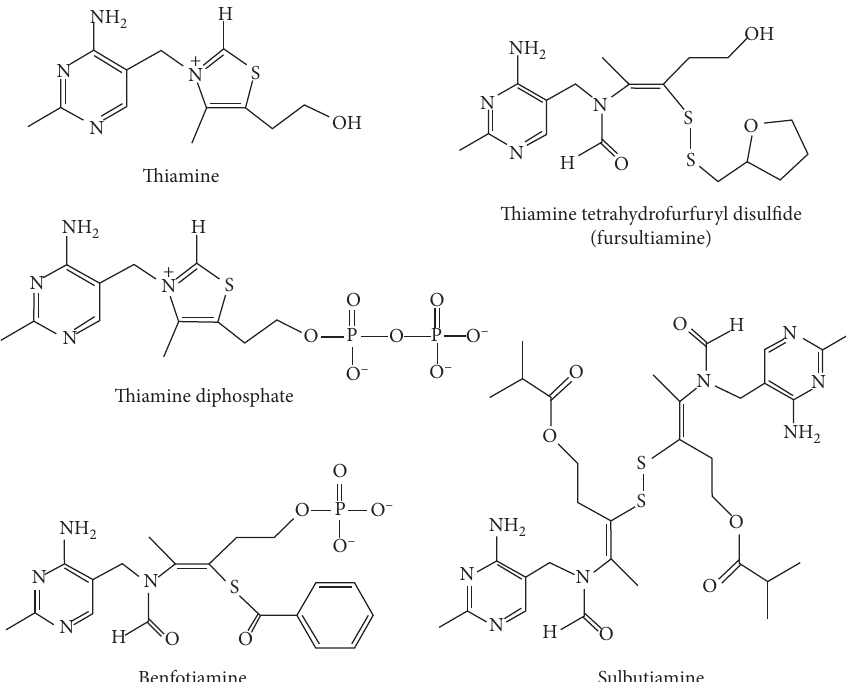
Figure 1: Structural formulas of thiamine, thiamine diphosphate, the thioester benfotiamine, and the disulfide compounds fursultiamine and sulbutiamine.